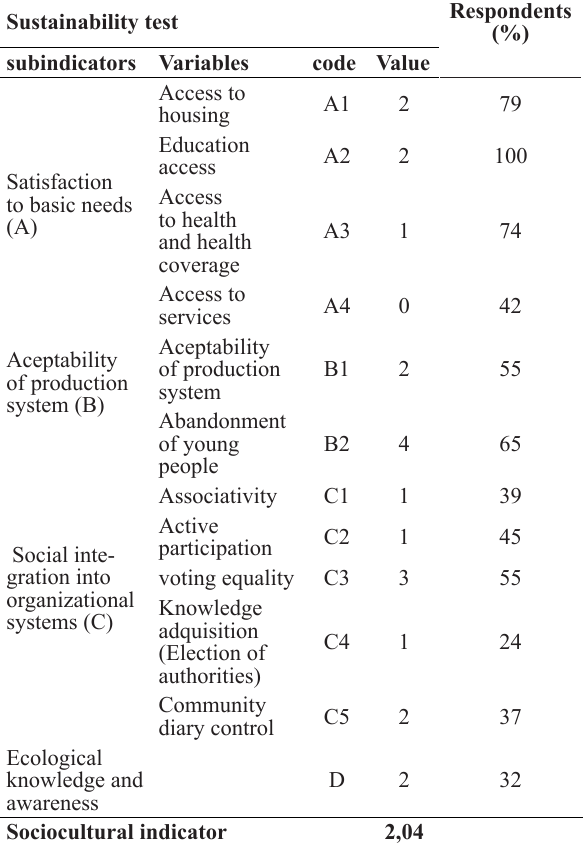
Table 7: Evaluation results of